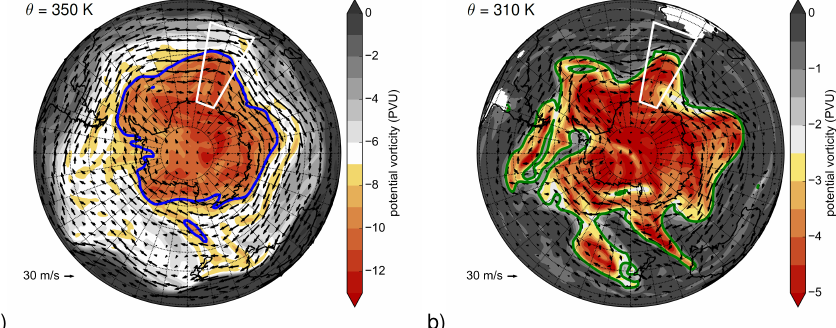
Figure 1. Dynamical situation with color-coded PV from ECMWF data on 13 September 2012 at 12:00UTC on two different potential temperature levels: (a) 350K and (b) 310K. The black arrows depict the wind vectors. The blue line represents the vortex edge at 350K (Nash et al., 1996) and the green line the − 2PVU isoline at the 310K level. The region of the ESMVal flight is marked by a white box.